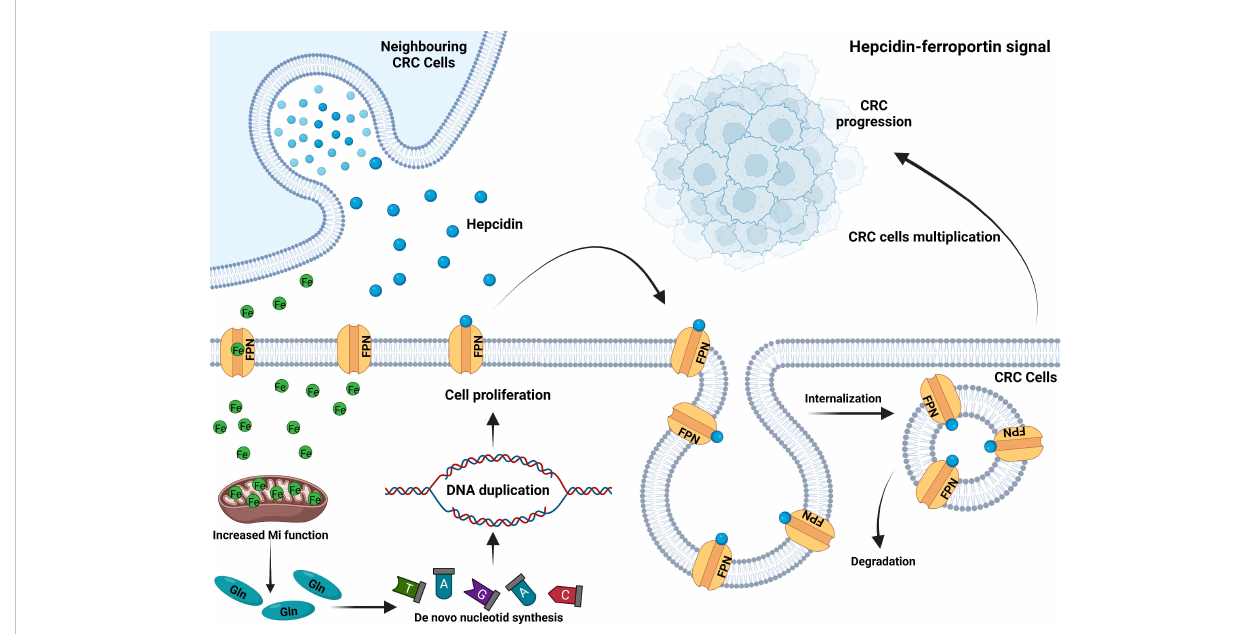
FIGURE 2 CRC ectopically expresses hepcidin to sequester iron. CRC cells secrete hepcidin in an autocrine or paracrine manner. Hepcidin binds to ferroportin on the plasma membrane, inducing its internalization and degradation. Thus, reduced iron exportat via FPN and sustained mitochondrial function to enhance glutamine production. Increased intracellular glutamine accelerates de novo nucleotide synthesis and DNA duplication, which leads to CRC cell proliferation and tumor progression